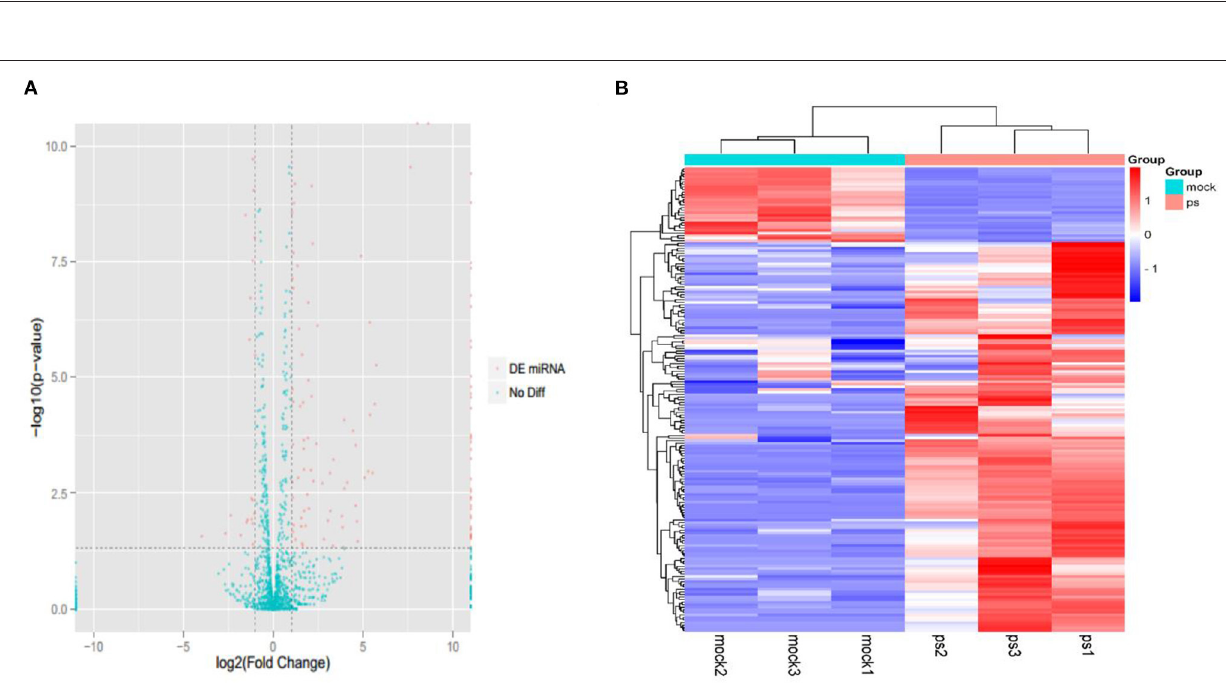
Frontiers in Veterinary Science |